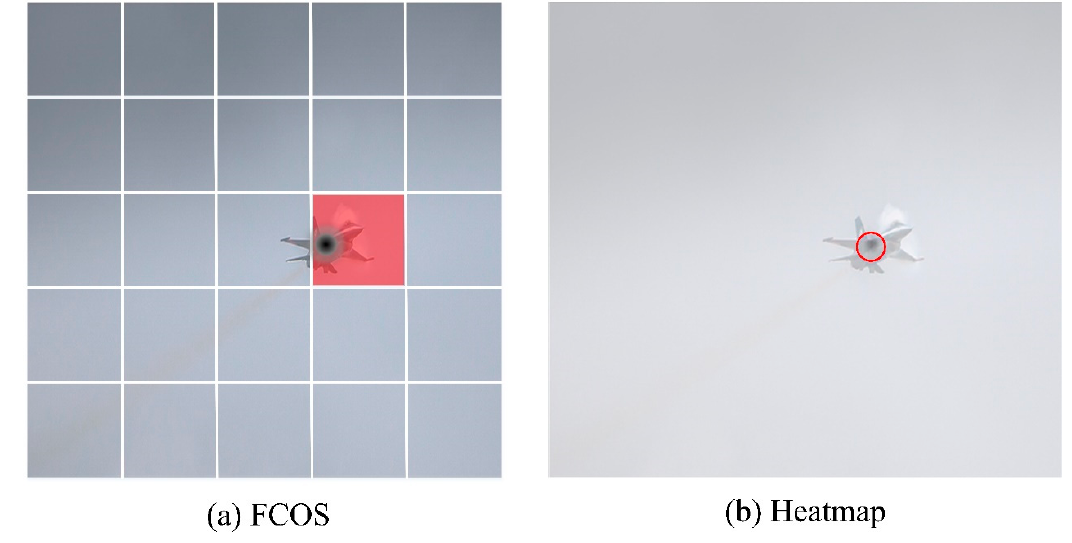
Figure 2. ( a ) Cell detection of FCOS algorithm. ( b ) Heatmap of OaP algorithm.